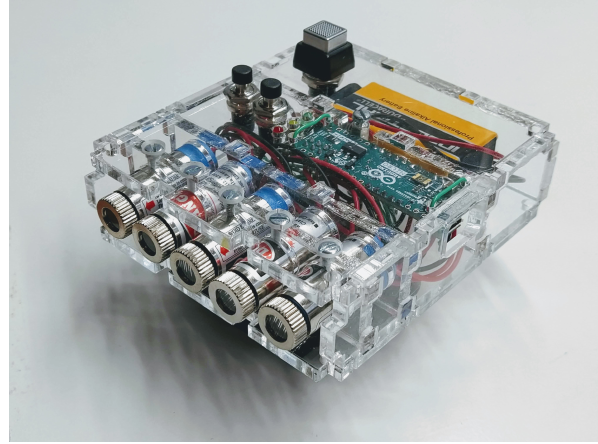
Figure 2. Example of a low-cost laser